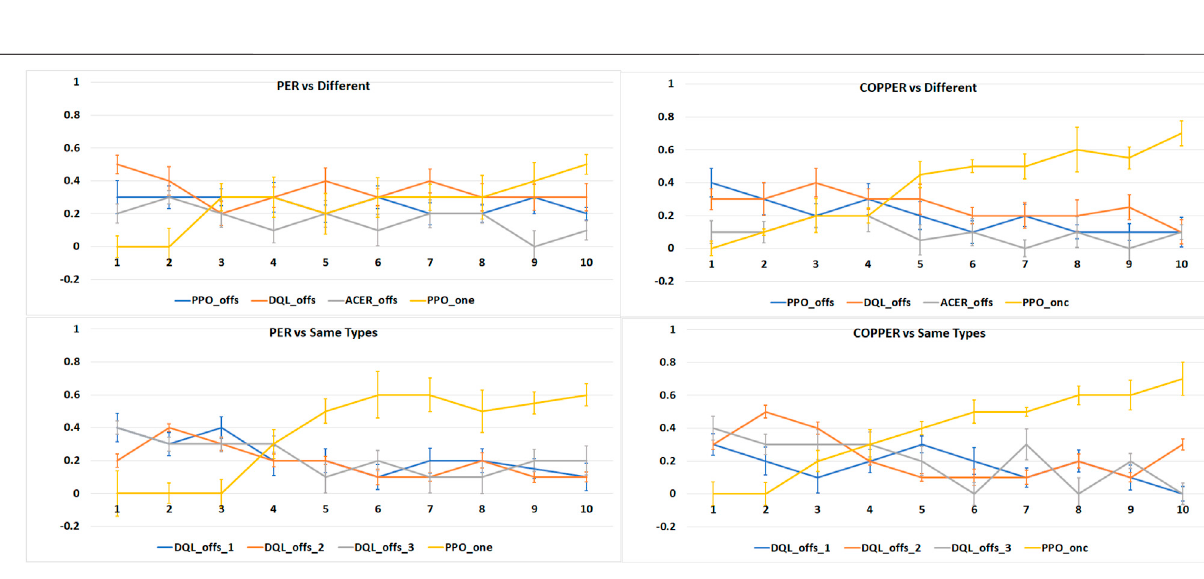
Frontiers in Robotics and AI |